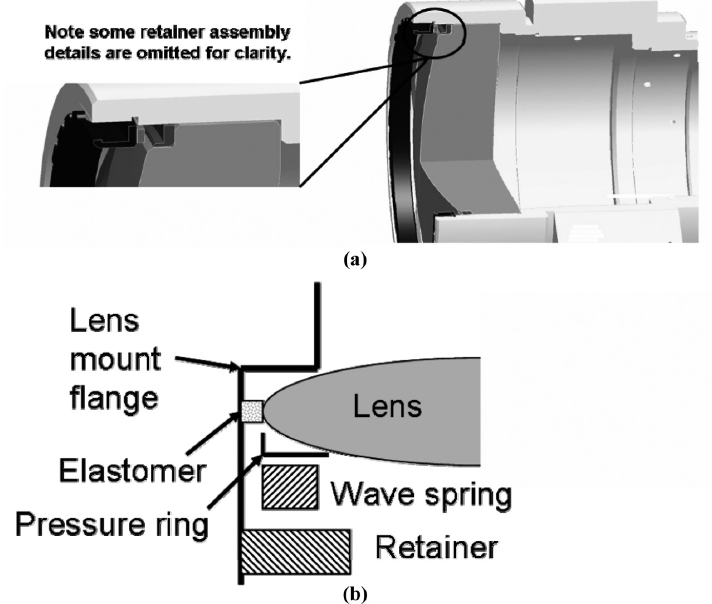
Fig. 1. (a) Single-lens optomechanical system, and (b) simpli fi ed